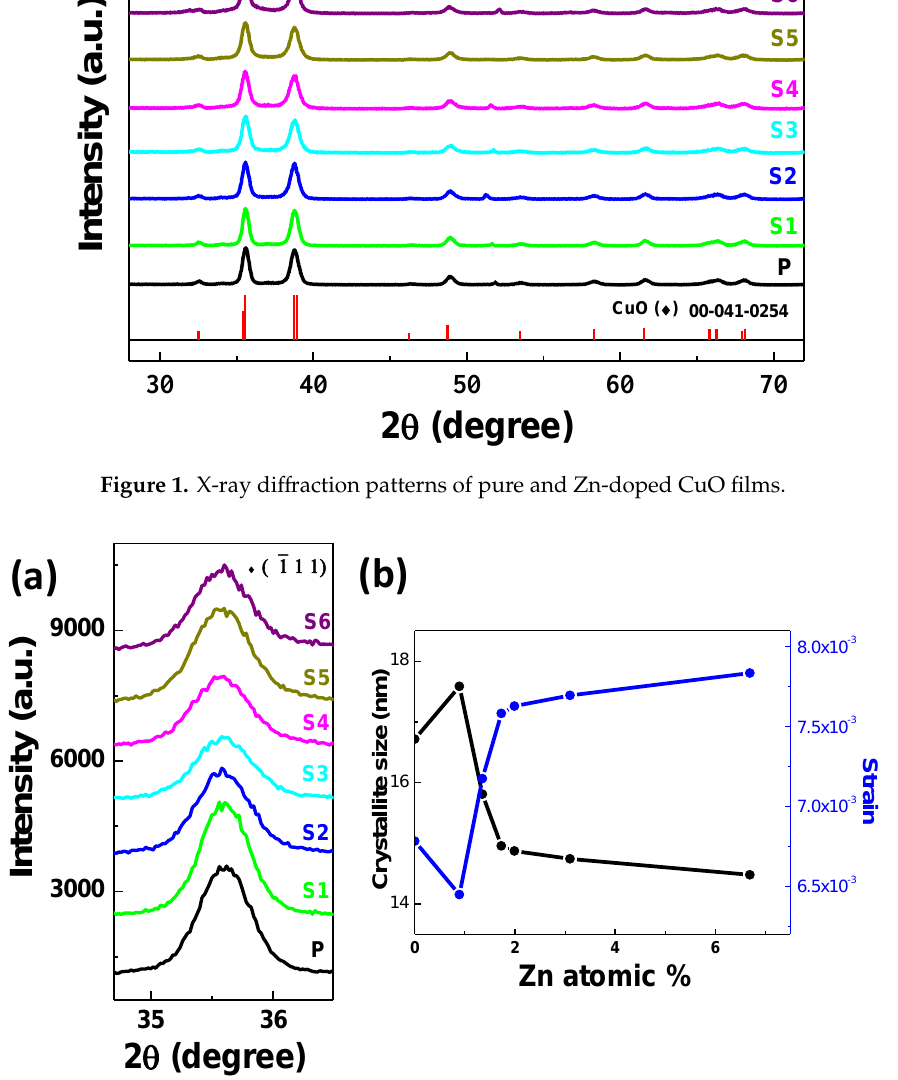
Figure 2. ( a ) XRD peak (1 1 1) of pure and Zn-doped CuO films and ( b ) the change in the crystallite size and strain as a function of Zn concentration. Table 1. Elemental composition of pure and Zn-doped CuO films.